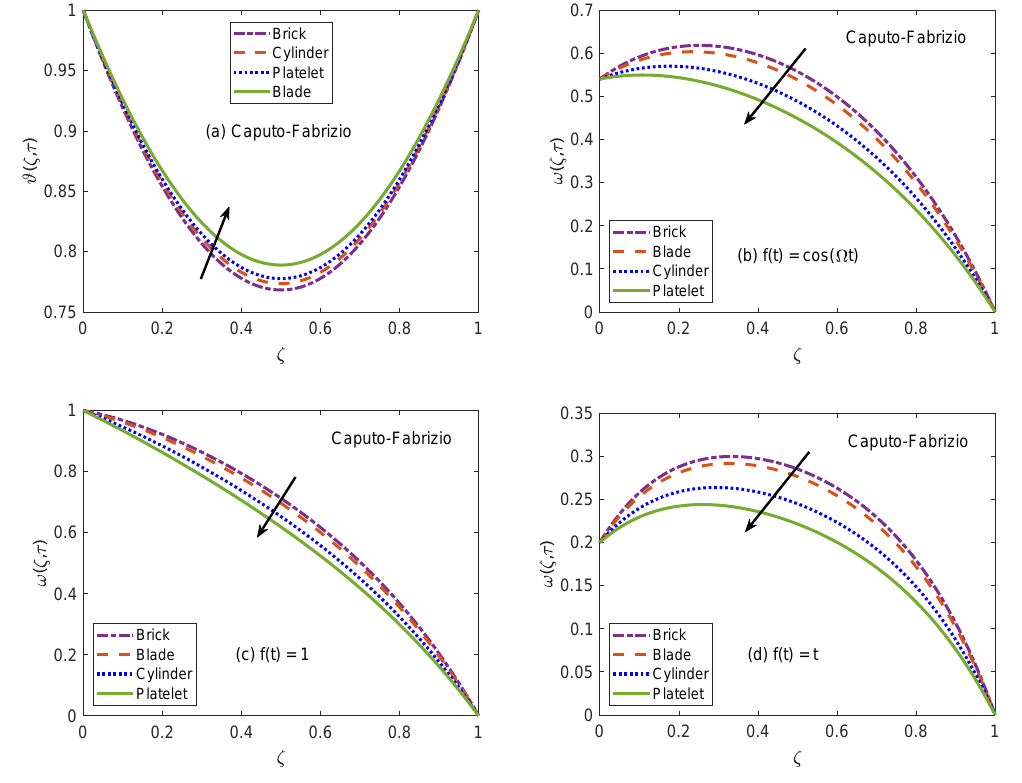
Figure 3. Temperature and velocity patterns of CF model for various shapes of